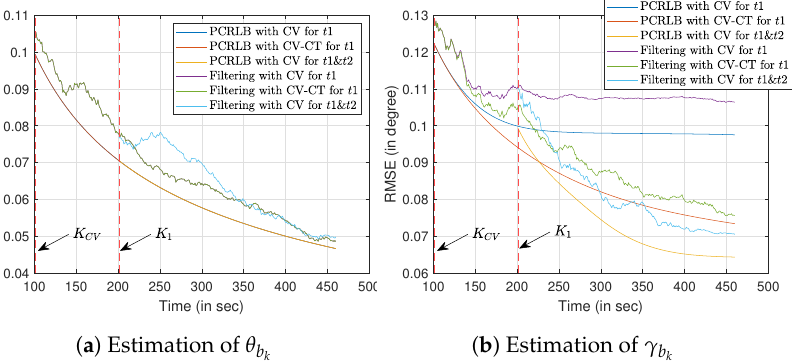
Figure 7. RMSE evaluation for bias estimation using two targets of opportunity with a known location. Terrain uncertainty is present with the target height information.